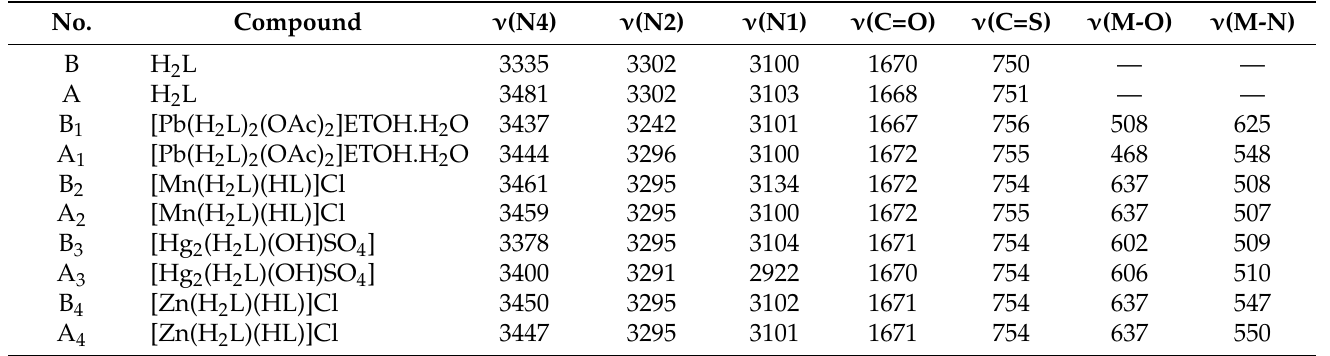
Table 2. Infrared spectral bands (cm − 1 ) for the ligand (H 2 L) and their metal